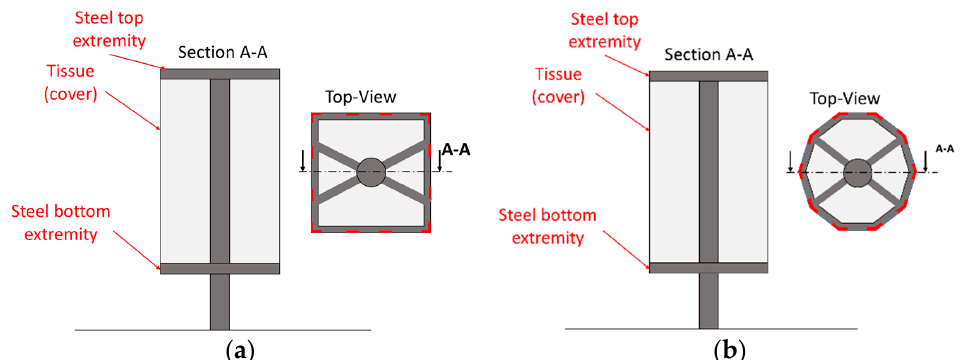
Figure 2. A schematic of the squared ( a ) and decagonal ( b ) structures under test. The positions of elastic belts are highlighted by using red lines, in the top view.